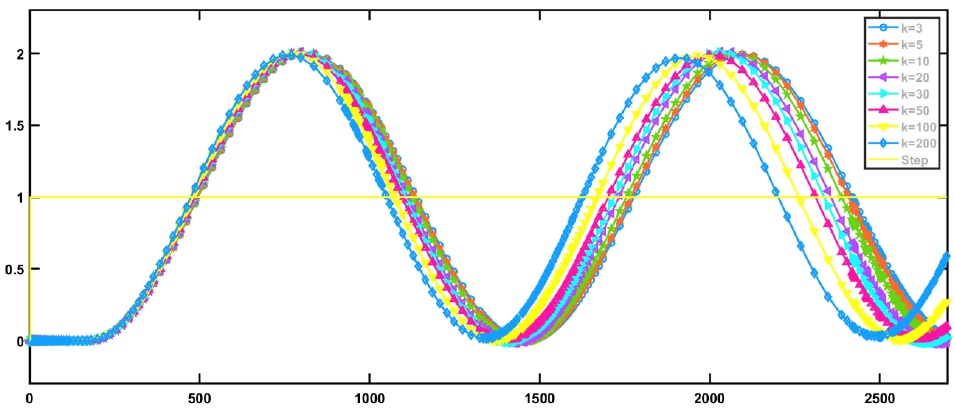
Figure 10. Step Response (Equal Amplitude Oscillation) of a Second-Order Time-Delay System for Different 𝐾 .